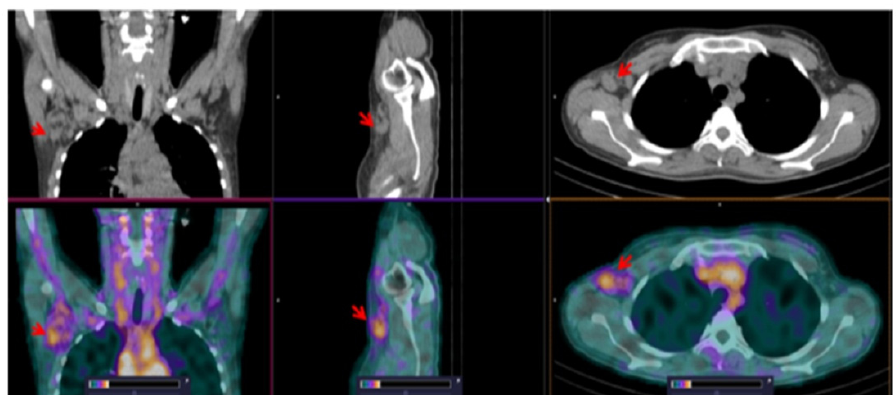
Figure 3. SPECT/CT images of patient 11 at 2 h after injection of [ 99m Tc]Tc-TG. An enlarged (up to 2.2 cm) right axillary node with elevated [ 99m Tc]Tc-TG uptake (SUVmax = 1.86) is visualized (arrows). The upper setting of the scale window (22% of the maximum number) was adjusted to visualize the lesion.